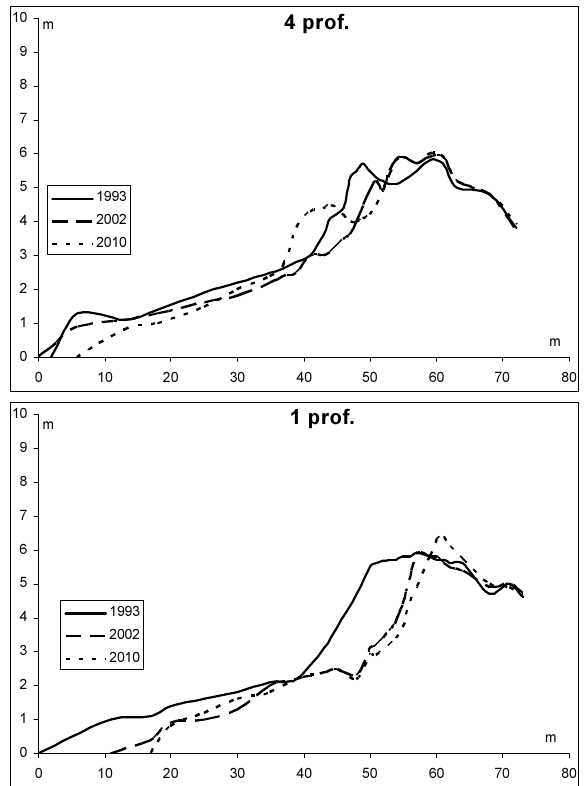
Fig. 7. The coast cross-profile changes to the north from the port jetties. Profile locations are marked in Fig.